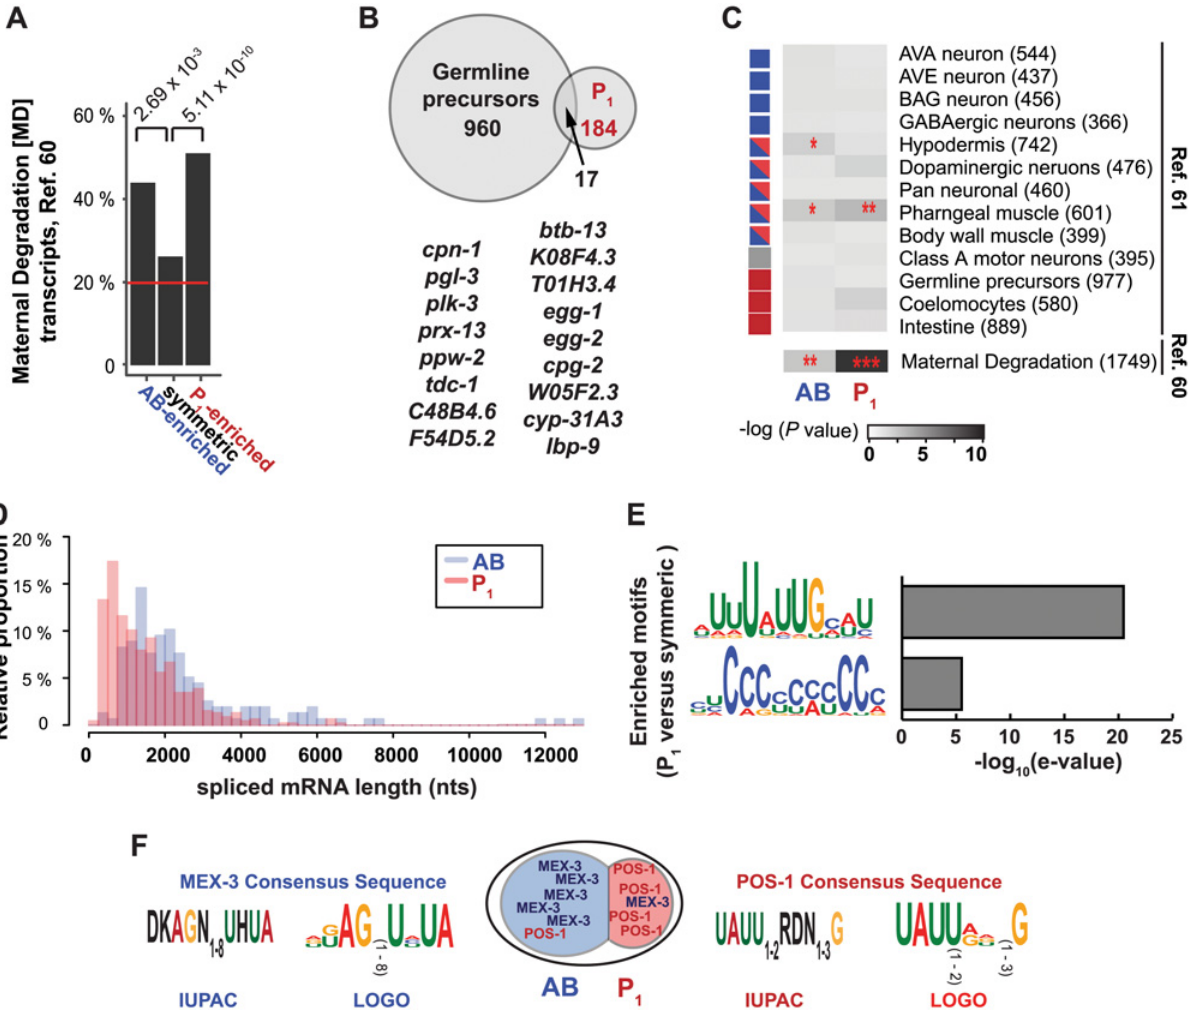
Fig 6. Characteristics of asymmetrically abundant genes. (A) The prevalence of Maternal Degradation [MD] transcripts (n = 1812) [60] among AB- enriched (n = 80), P 1 -enriched (n = 201), and symmetric transcripts (n = 2815). MD transcripts make up 19.8% of genes expressed at the 2-cell stage (horizontal red line). (B) Overlap between the P 1 -enriched gene set and transcripts enriched in Z 2 and Z 3 cells [61]. All individual genes that overlap are listed. (C) Association of cell-type specific transcripts [61] with the AB-enriched and P 1 -enriched gene sets. ( * P < 5x10 -2 ; ** P < 5x10 -3 ; *** P < 5x10 -9 , by Fisher ’ s exact test). Squares on the left indicate the lineage of origin for each tissue or cell type (blue = AB-lineage, blue and red = AB and P 1 lineages, red = P 1 - lineage). For comparison, overlap between the MD transcripts (Fig 6A) is also plotted. (D) Lengths of spliced gene models for AB-enriched genes and P 1 - enriched genes plotted as a histogram. The P value for the likelihood that the two distributions were drawn from the same population was calculated using Wilcoxon rank-sum (Mann-Whitney U ) test with continuity correction ( P < 1.0x10 -16 for all genes and P = 1.22x10 -15 when the three outlying AB-enriched gene models were excluded). (E) Identification of de novo RNA sequence motifs specific to the 3 0 UTRs of P 1 -enriched transcripts as compared to symmetric transcripts [62]. No significant motifs were identified between AB-enriched transcripts compared to symmetric transcripts. (F) POS-1 and MEX-3 proteins are known to be asymmetrically localized at the 2-cell stage of development. The consensus sequences required for POS-1 [63] and MEX-3 [64] recognition are shown as IUPAC codes and transformed into WEBLOGOs for ease of comparison with de novo logos (Fig